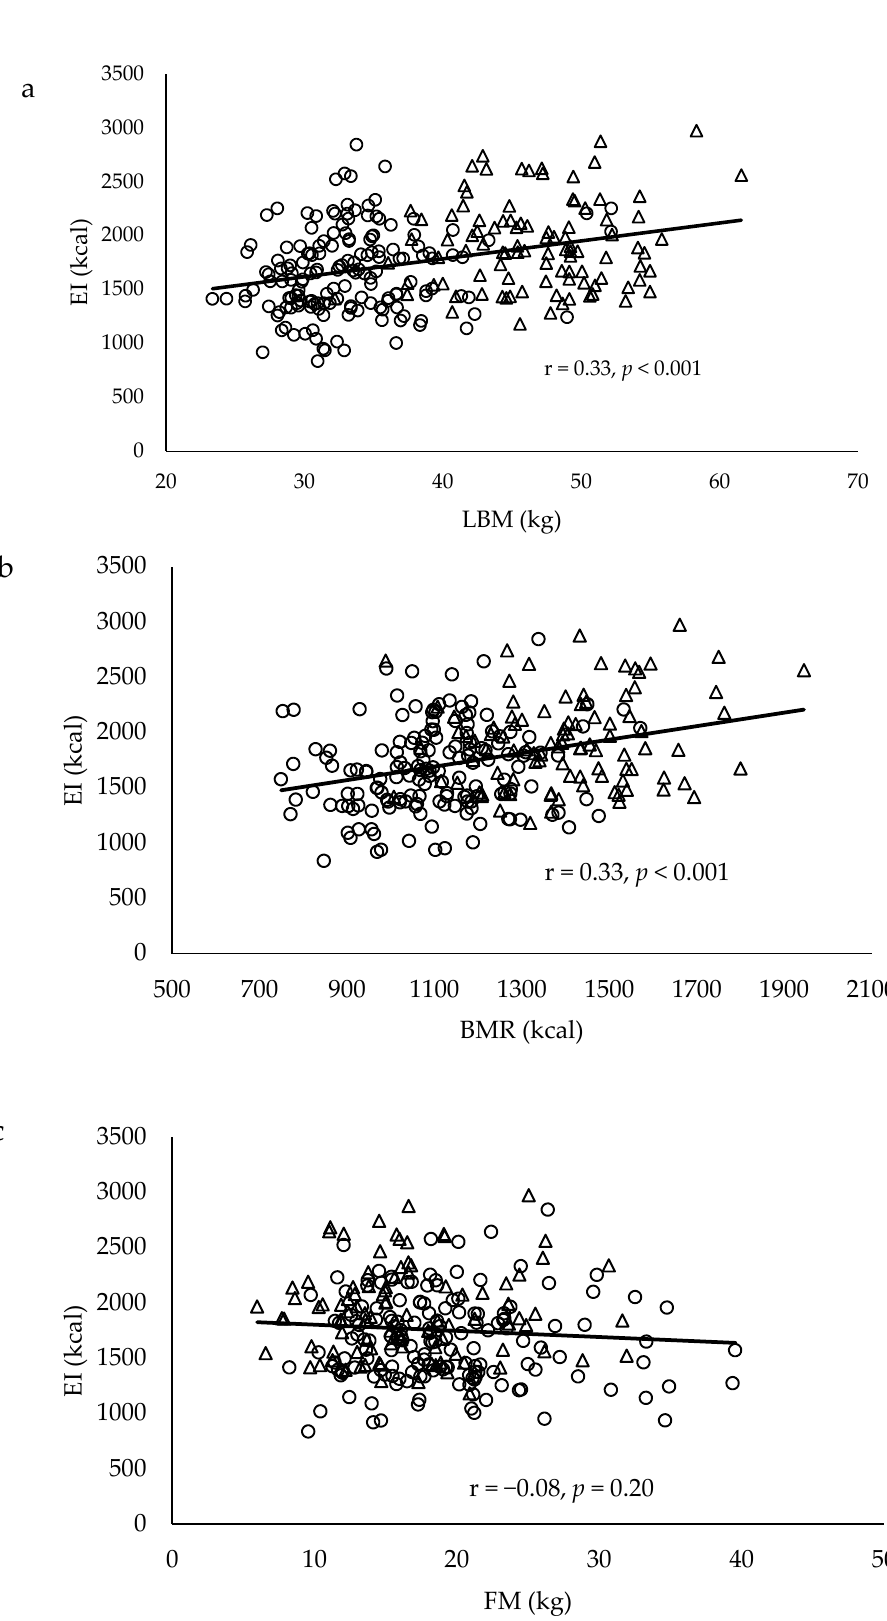
Figure 1. Scatter plots to illustrate the relationship between ( a ) LBM, ( b ) BMR, and ( c ) FM and daily EI. The relationships indicate significant correlation between LBM, BMR, and daily EI, but not FM. Males were represented by the open triangles and females were represented by the open circles. Table 3. Sex-specific multivariable-adjusted regressions analysis for body composition variables with daily macronutrient intakes of the study population.